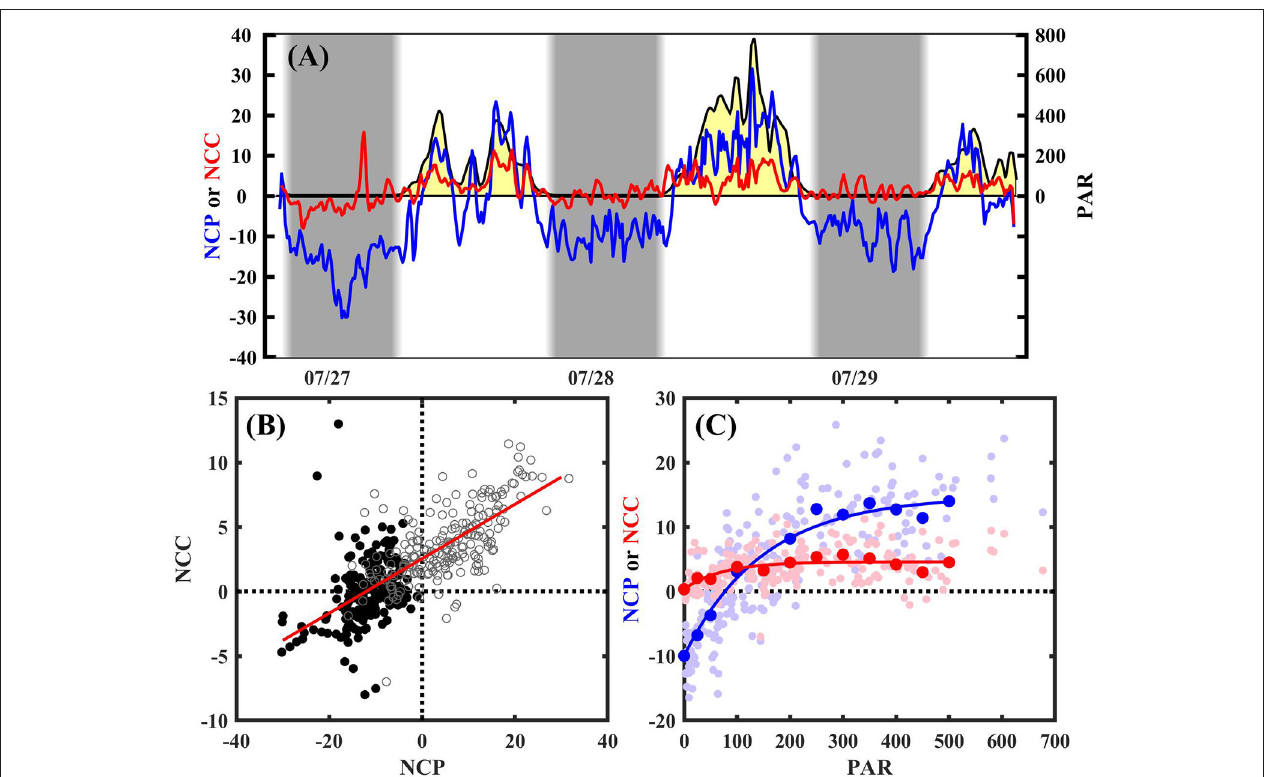
FIGURE 3 | (A) Benthic NCP (blue; mmol O 2 m − 2 h − 1 ), NCC (red; mmol CaCO 3 m − 2 h − 1 ), and PAR (shaded yellow; µ mol photons m − 2 s − 1 ) measured every 10min at site T3. Gray background represents night time. (B) NCP vs. NCC during the day (open gray circles) and night (black circles). Model II regression is shown in red, with slope = 0.21 ± 0.01 ( R 2 = 0.48) (C) NCP-Irradiance (blue) and NCC-Irradiance (red) curve for daytime data. Small dots are individual measurements, whereas larger solid dots represent binned averages (0, 25, 50, then every 50 until 500). Solid lines represent